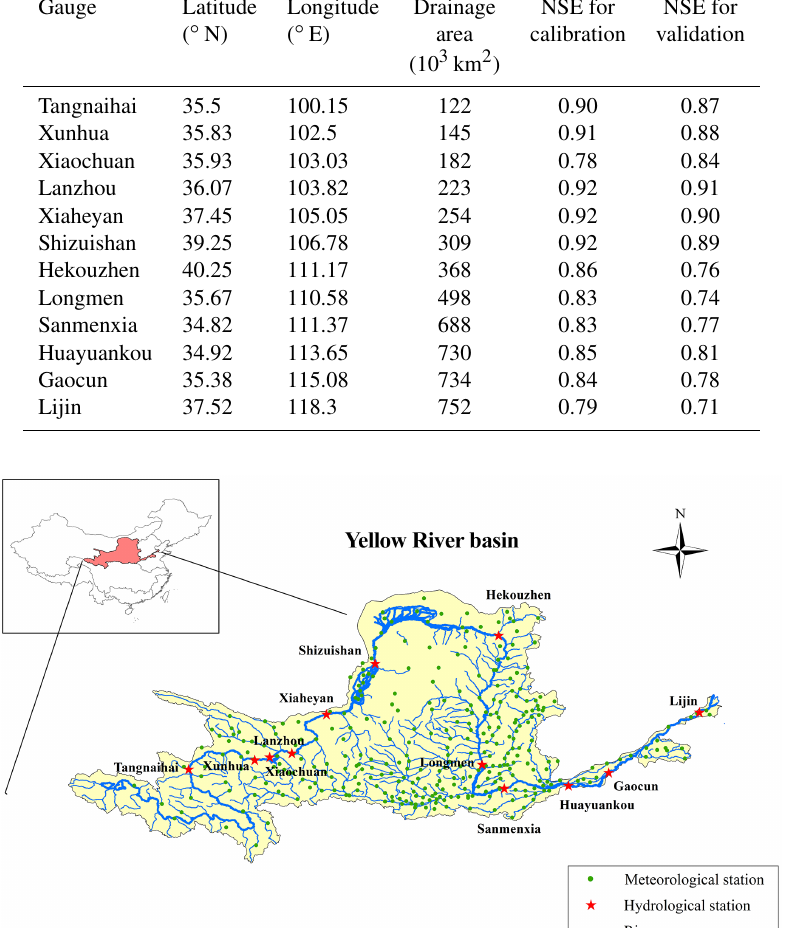
Figure 1. Locations of meteorological and hydrological stations over the Yellow River